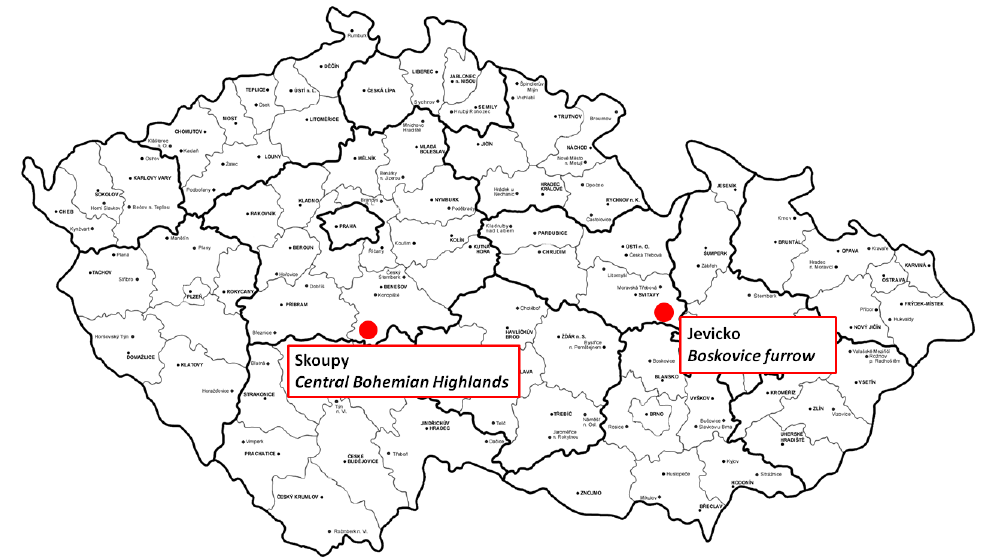
Figure 1. The research areas with experiments focused on soil protection technologies—Jevíčko and Skoupý.